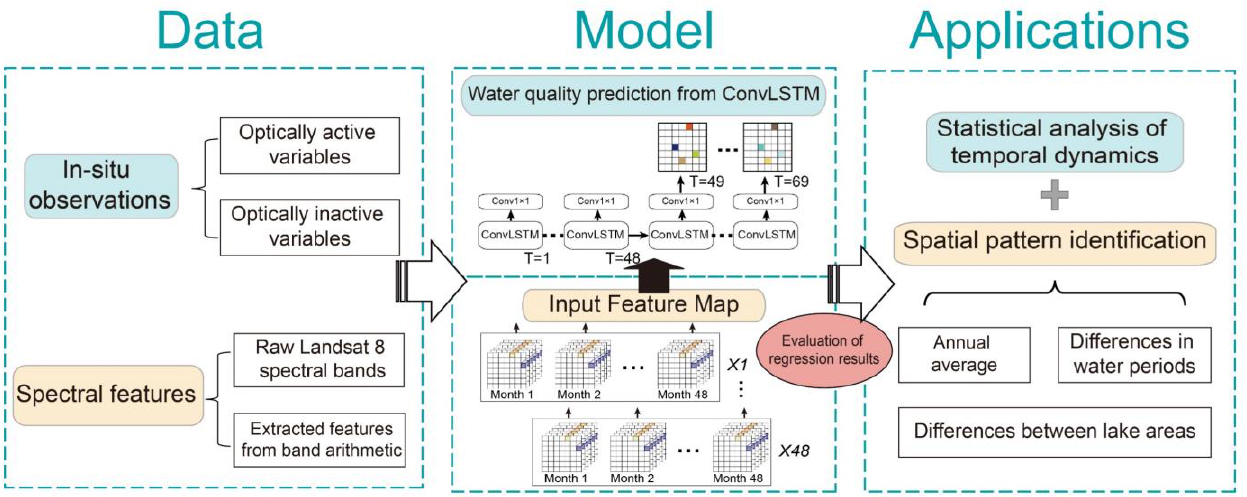
Figure 1. A framework for water quality variable retrieval and spatiotemporal analysis based on remote sensing and deep learning techniques.